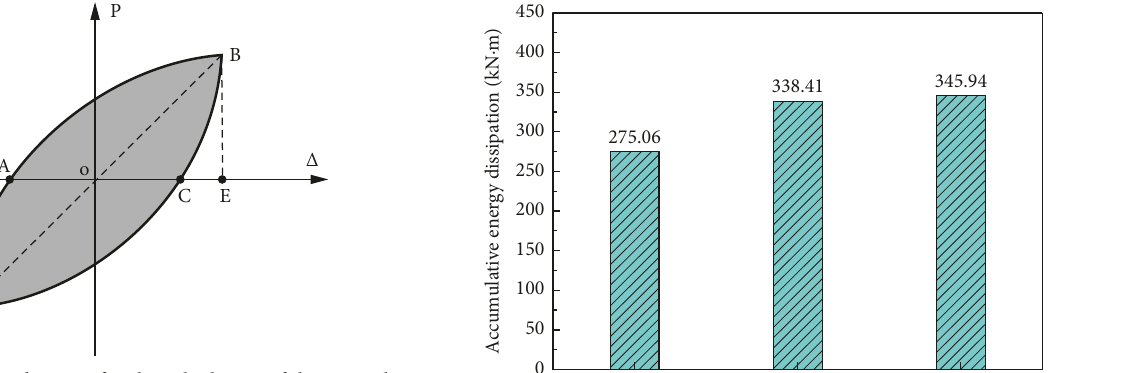
Figure 15: Schematic diagram for the calculation of the equivalent viscous damping coefficient.